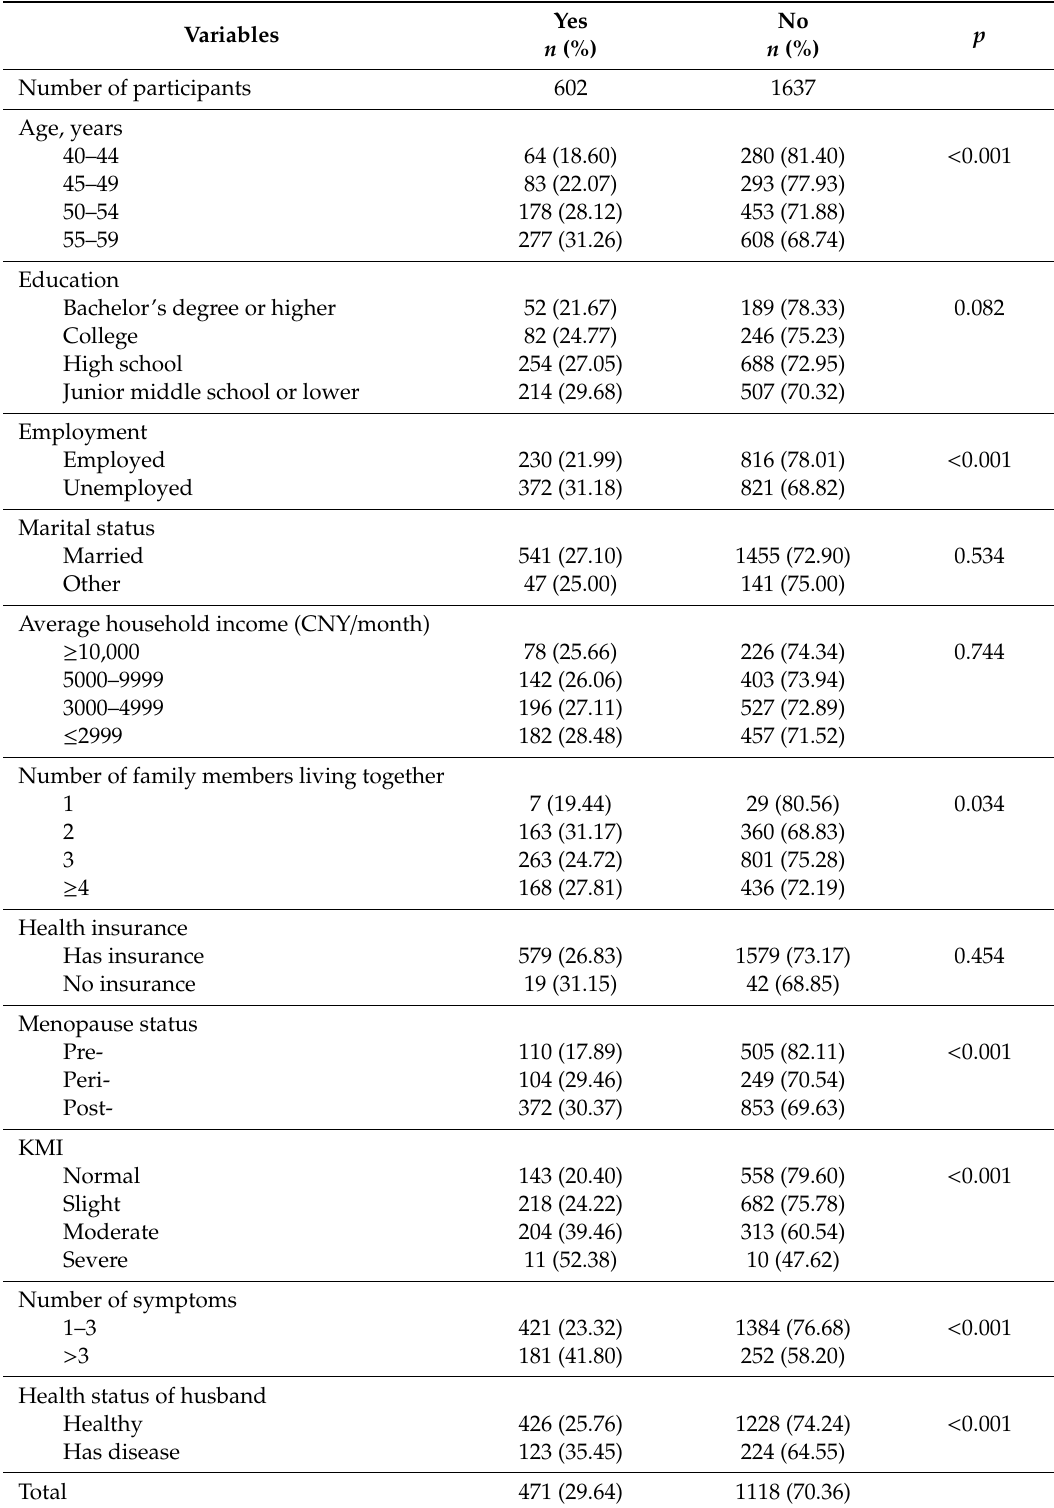
Table 4. Influencing factors of seeking healthcare among women with menopausal